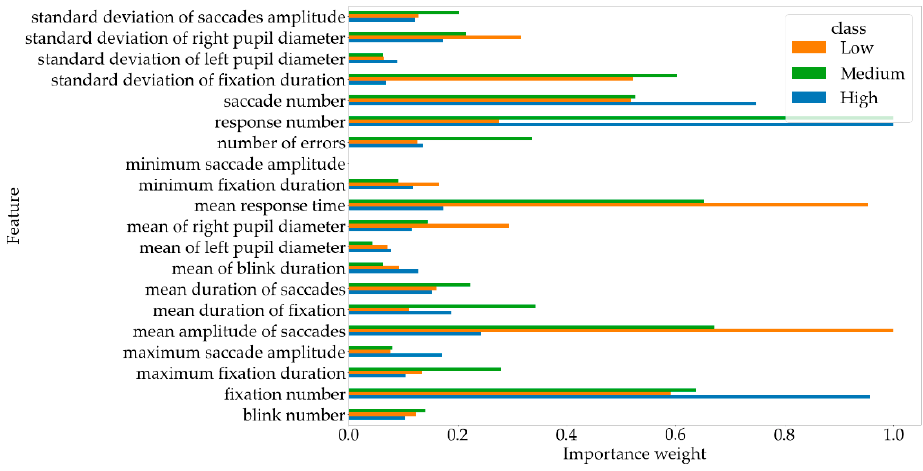
Figure 4. Separate feature importance weights.